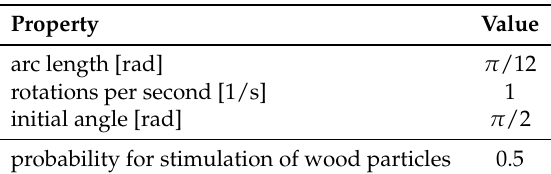
Table 3. Properties of mixing arm for all scenarios.